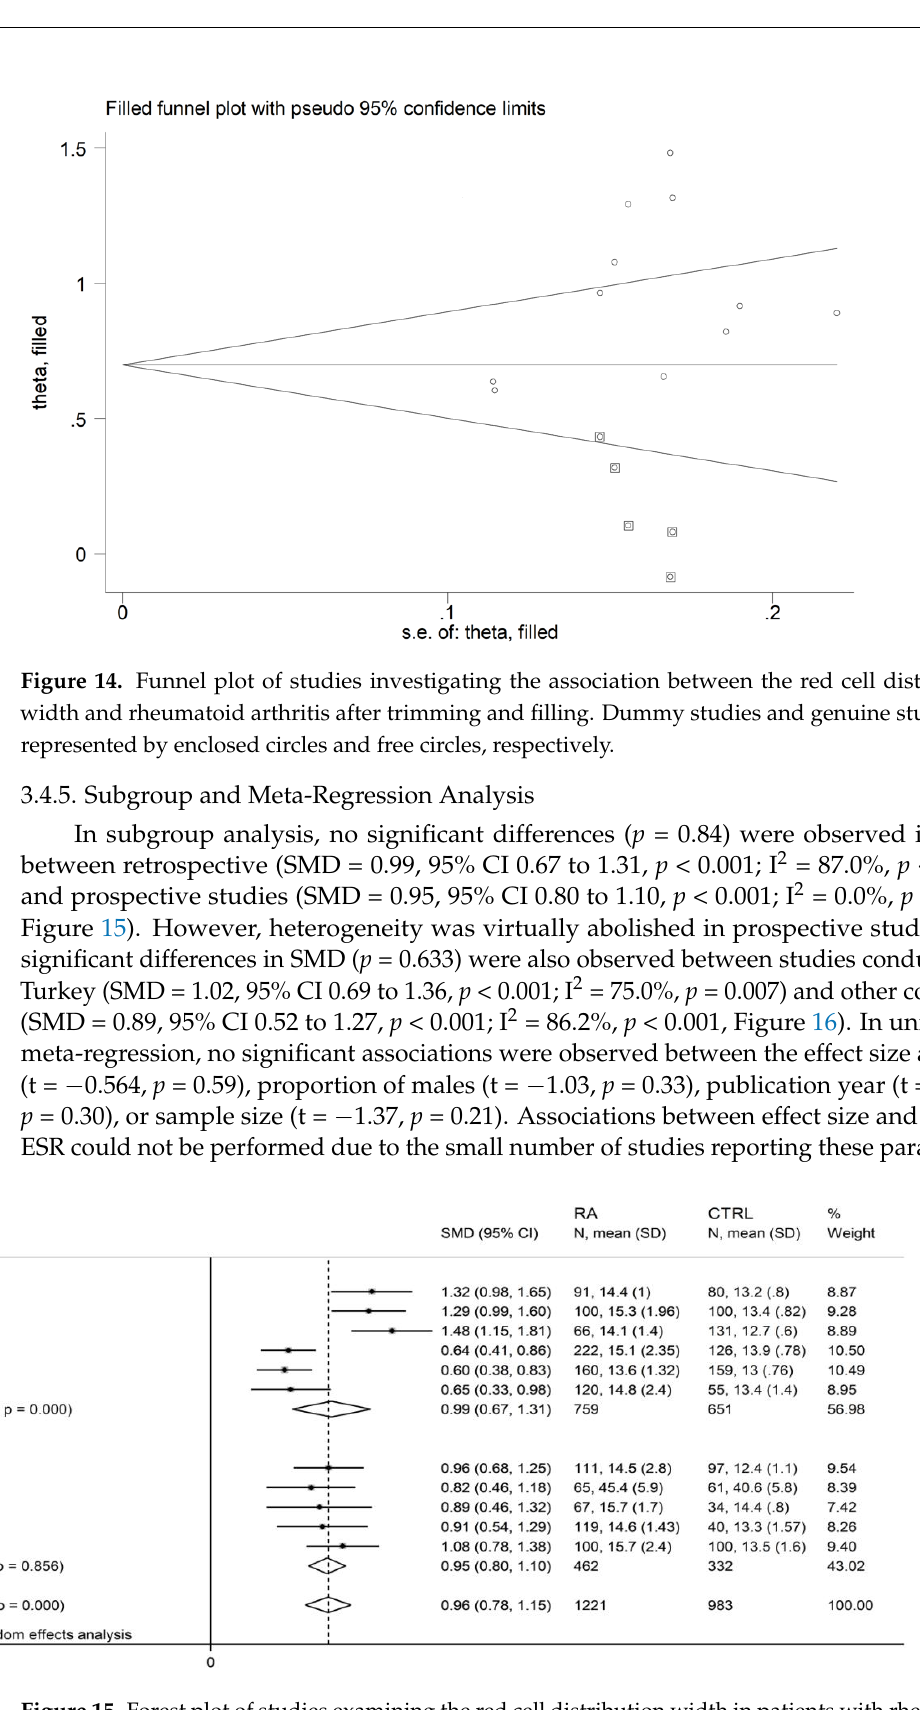
13 of 20 Figure 12. Forest plot of studies examining the red cell distribution width in patients with rheuma- toid arthritis and healthy controls. Figure 13. Sensitivity analysis of the association between the red cell distribution width and rheu- matoid arthritis. For each study, the displayed effect size (hollow circles) corresponds to an overall effect size computed from a meta-analysis excluding that study.